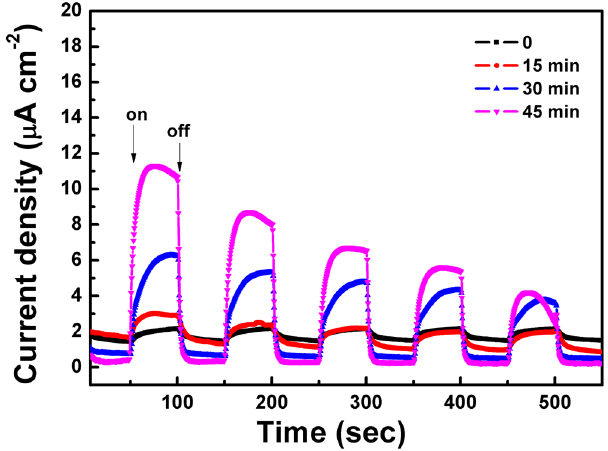
Figure 7. Transient photocurrent responses of the obtained Bi 2 Fe 4 O 9 samples with different etching times.